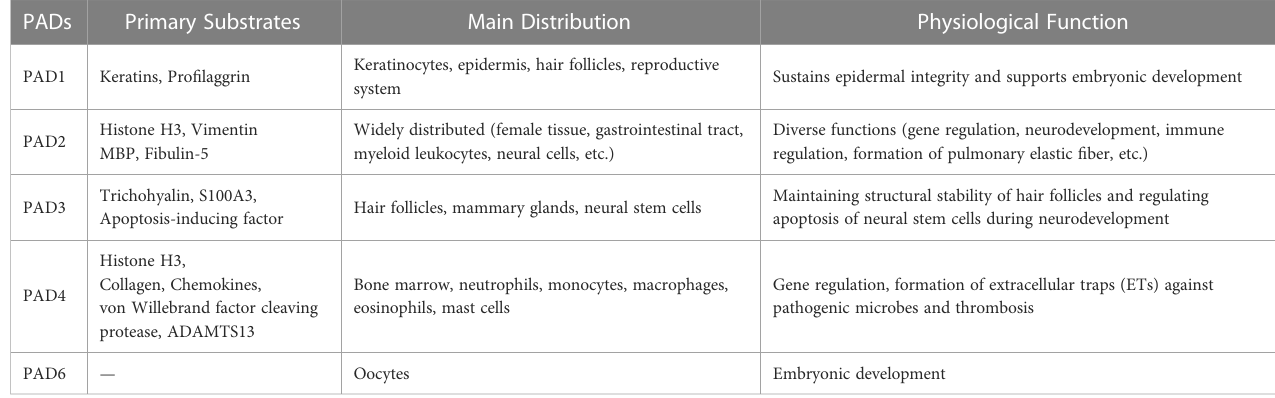
TABLE 1 Primary Substrates, distribution, and physiological functions of PADs.